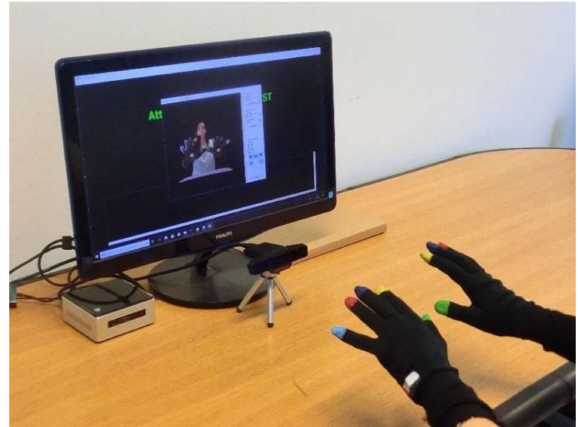
Figure 1. System for the upper limbs analysis: RGB-Depth camera (Intel RealSense ® SR300); NUC i7 Intel ® mini-PC; lightweight gloves with color